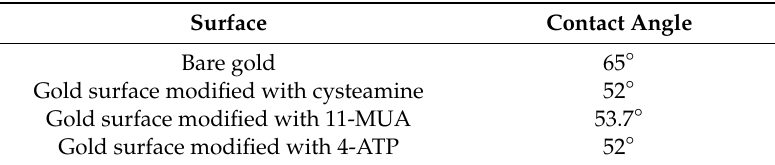
Table 2. Contact angle